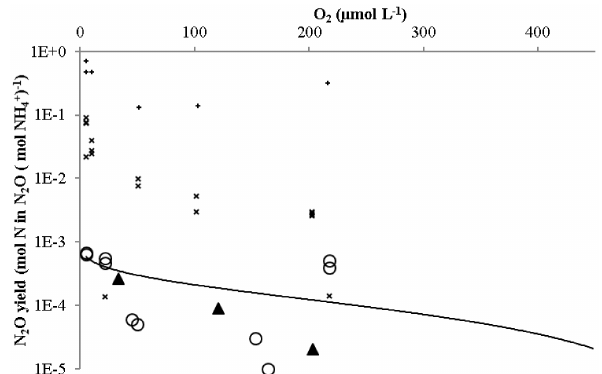
Figure 5. N 2 O yield of nitrification (N atom : atom) as a function of O 2 concentration; filled triangles: AOA (Loescher et al., 2012); open circles: AOB at low to medium cell numbers (Frame and Cas- ciotti, 2010; Loescher et al., 2012); crosses: marine AOB at high cell numbers (Goreau et al., 1980; Frame and Casciotti, 2010); plusses: soil AOB at high cell numbers (Lipschultz et al., 1981). Black line: logarithmic fit to AOA and low to medium cell number AOB (yield + = 0 . 791 − 0 . 126 · ln(O ) − 1 ). 2 )mmolN in N 2 O (molNH 4 N 2 O during oxic nitrification (blue arrows in Fig. 1) and